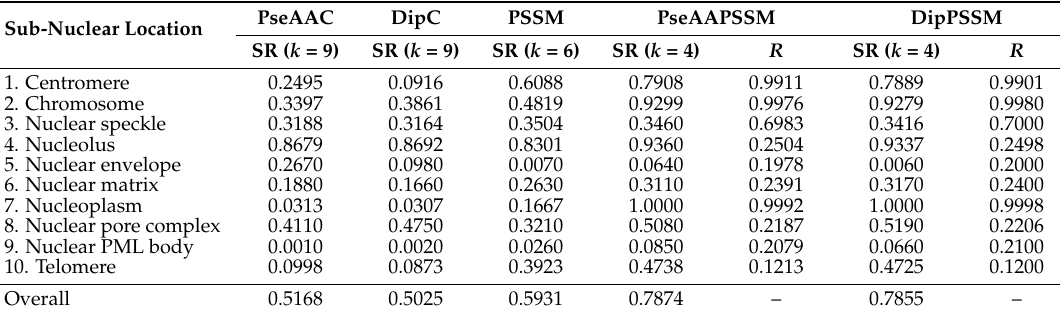
Table 5. Prediction success rate (SR) and the optimal R of Dataset 2 for protein sub-nuclear localization by 10-fold cross validation with different